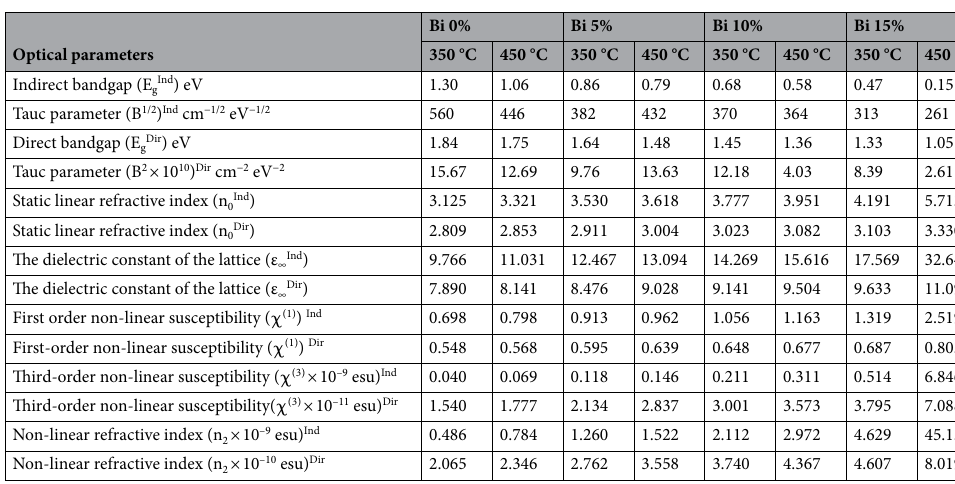
Table 3. Linear and nonlinear optical parameters of the annealed Bi x In 35-x Se 65 thin films.